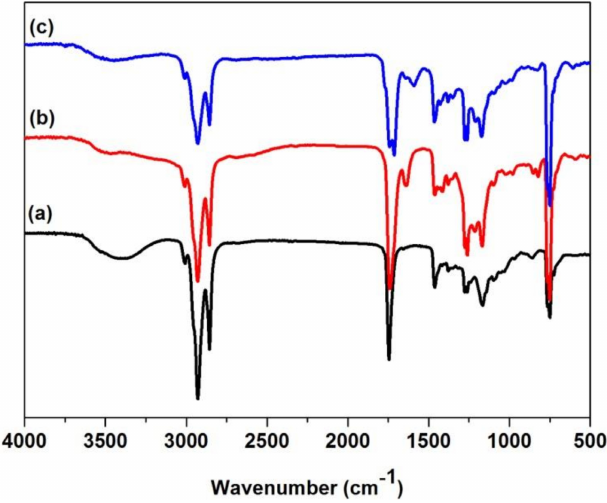
Figure 2. The FTIR spectra of samples: ( a ) castor oil, ( b ) CCO and ( c )